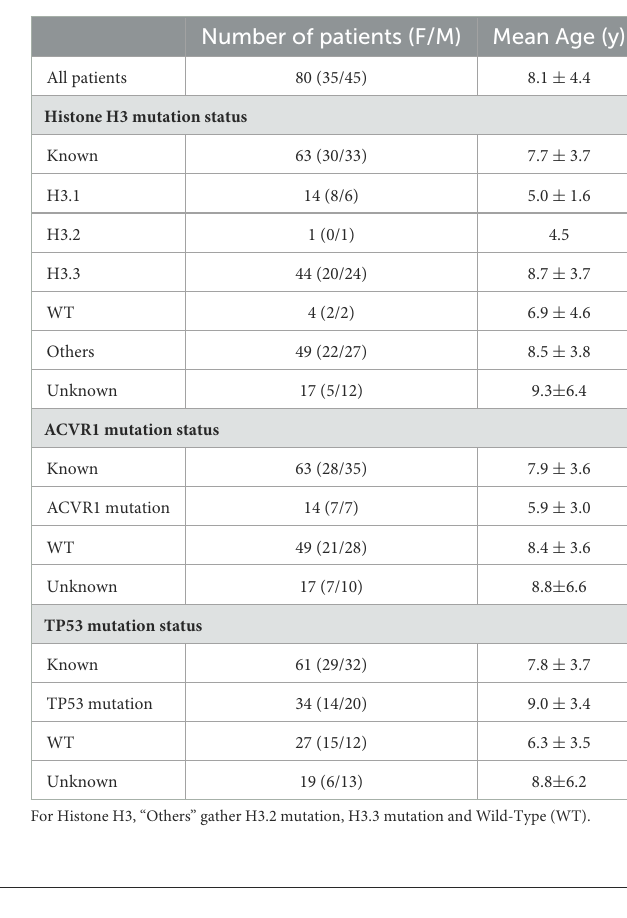
TABLE 2 Main clinical (age and sex) and molecular features.